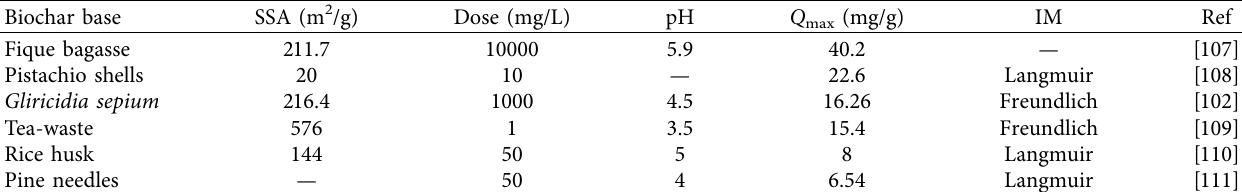
Table 7: Summary of characteristics of biochar adsorbents and conditions of the adsorption process. Biochar base